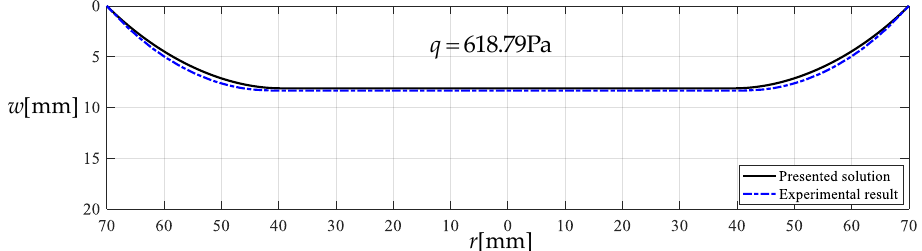
Figure 8. Deflection profiles for q = 618.79 Pa, drawn by experimental data and analytical solution.